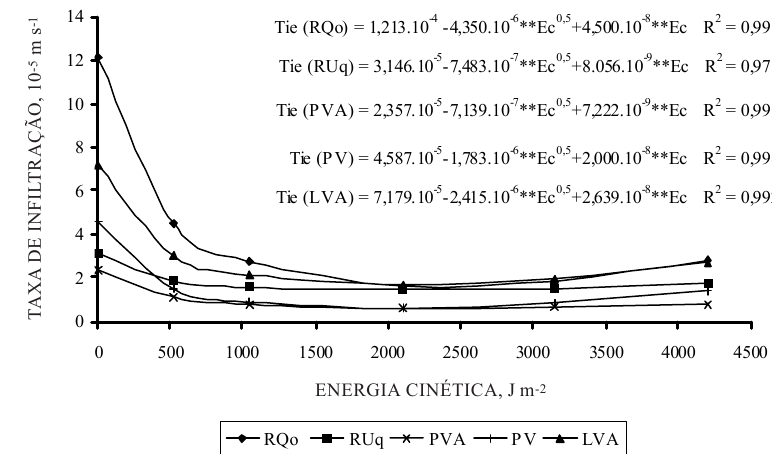
Figura 2. Taxa de infiltração estável (Tie), considerando a energia cinética aplicada (Ec) e a classe de solo (** significativo a 1 % pelo teste t). Sendo: PV = Argissolo Vermelho; PVA = Argissolo